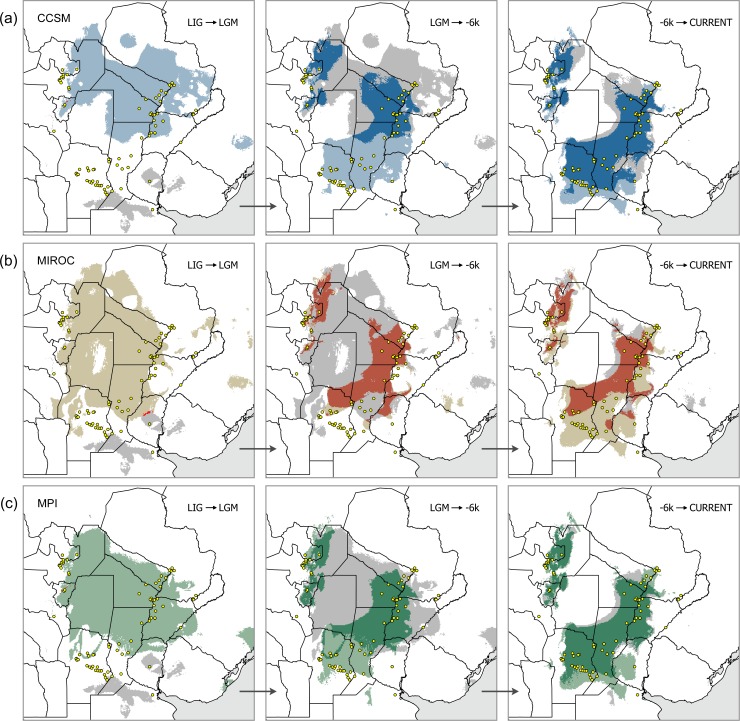
Paleodistributional shifts of Discocyrtus dilatatus during the Upper Quaternary, as predicted on three different GCM simulations.(a) CCSM, (b) MIROC and (c) MPI. Grey: areas of the precedent chronology lost during each transition. Color: new range (lighter, areas gained via expansion; darker, areas shared with previous stage). In the case of LIG to LGM transitions, the very few grid-cells shared are in red, to improve contrast. Maps were designed using free spatial data available at http://www.diva-gis.org/Data.